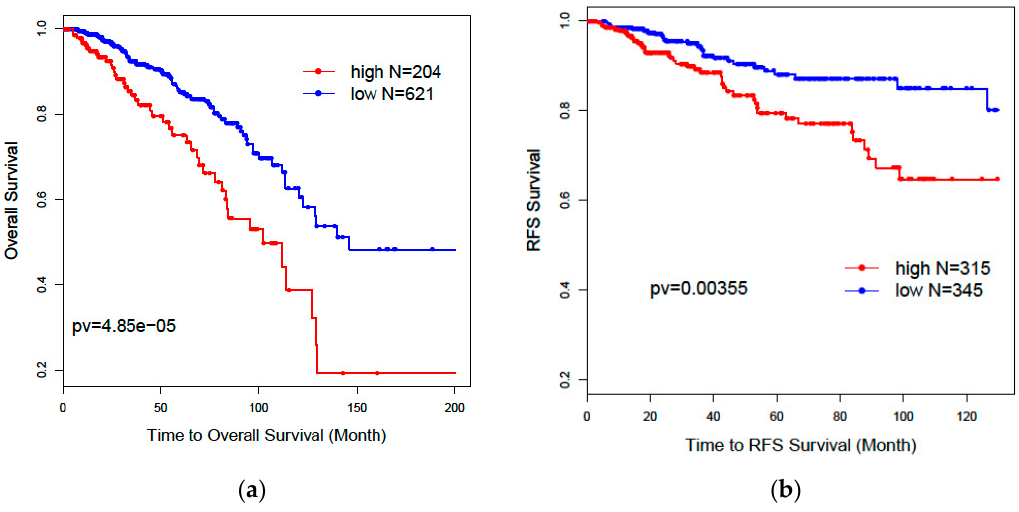
Figure 3. Kaplan–Meier curves and log-rank test p -values for overall survival ( a ) and recurrence-free survival ( b ) for the 36 “all” gene signature from 839 RNAseq data.